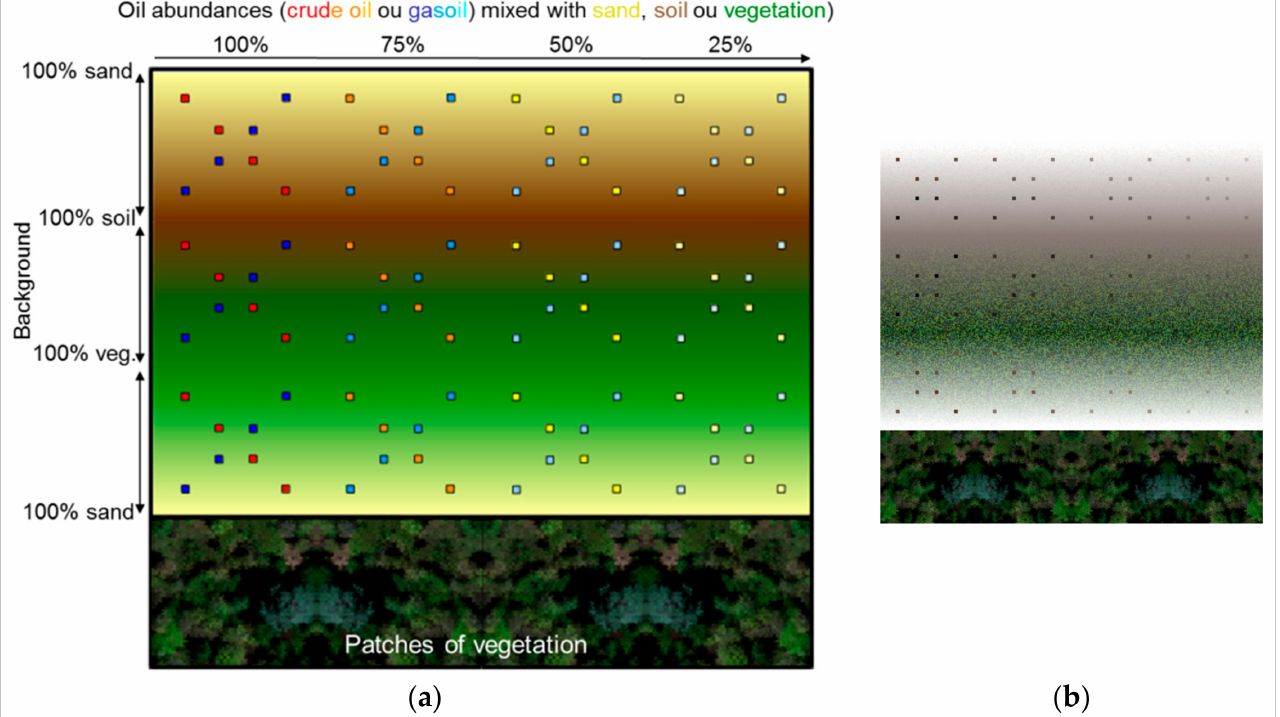
Figure 2. Composition of the synthetic image and simulated image (RGB). In ( a ) the red, orange, and yellow squares refers to the location of crude oil mixtures with a gradation from red to yellow corresponding to decreasing percentage values of crude oil in the pixels from 100% to 25%. The blue squares correspond to gasoil mixtures with the same gradation from dark to light blue. Yellow background is sand, the green one is vegetation and the marron one, soil, with a vertical gradation to symbolize the relative percentage of two types of background in the pixels. The lower part of the image is real patches of vegetation extracted from the image. ( b ) is the RGB extract of the simulated